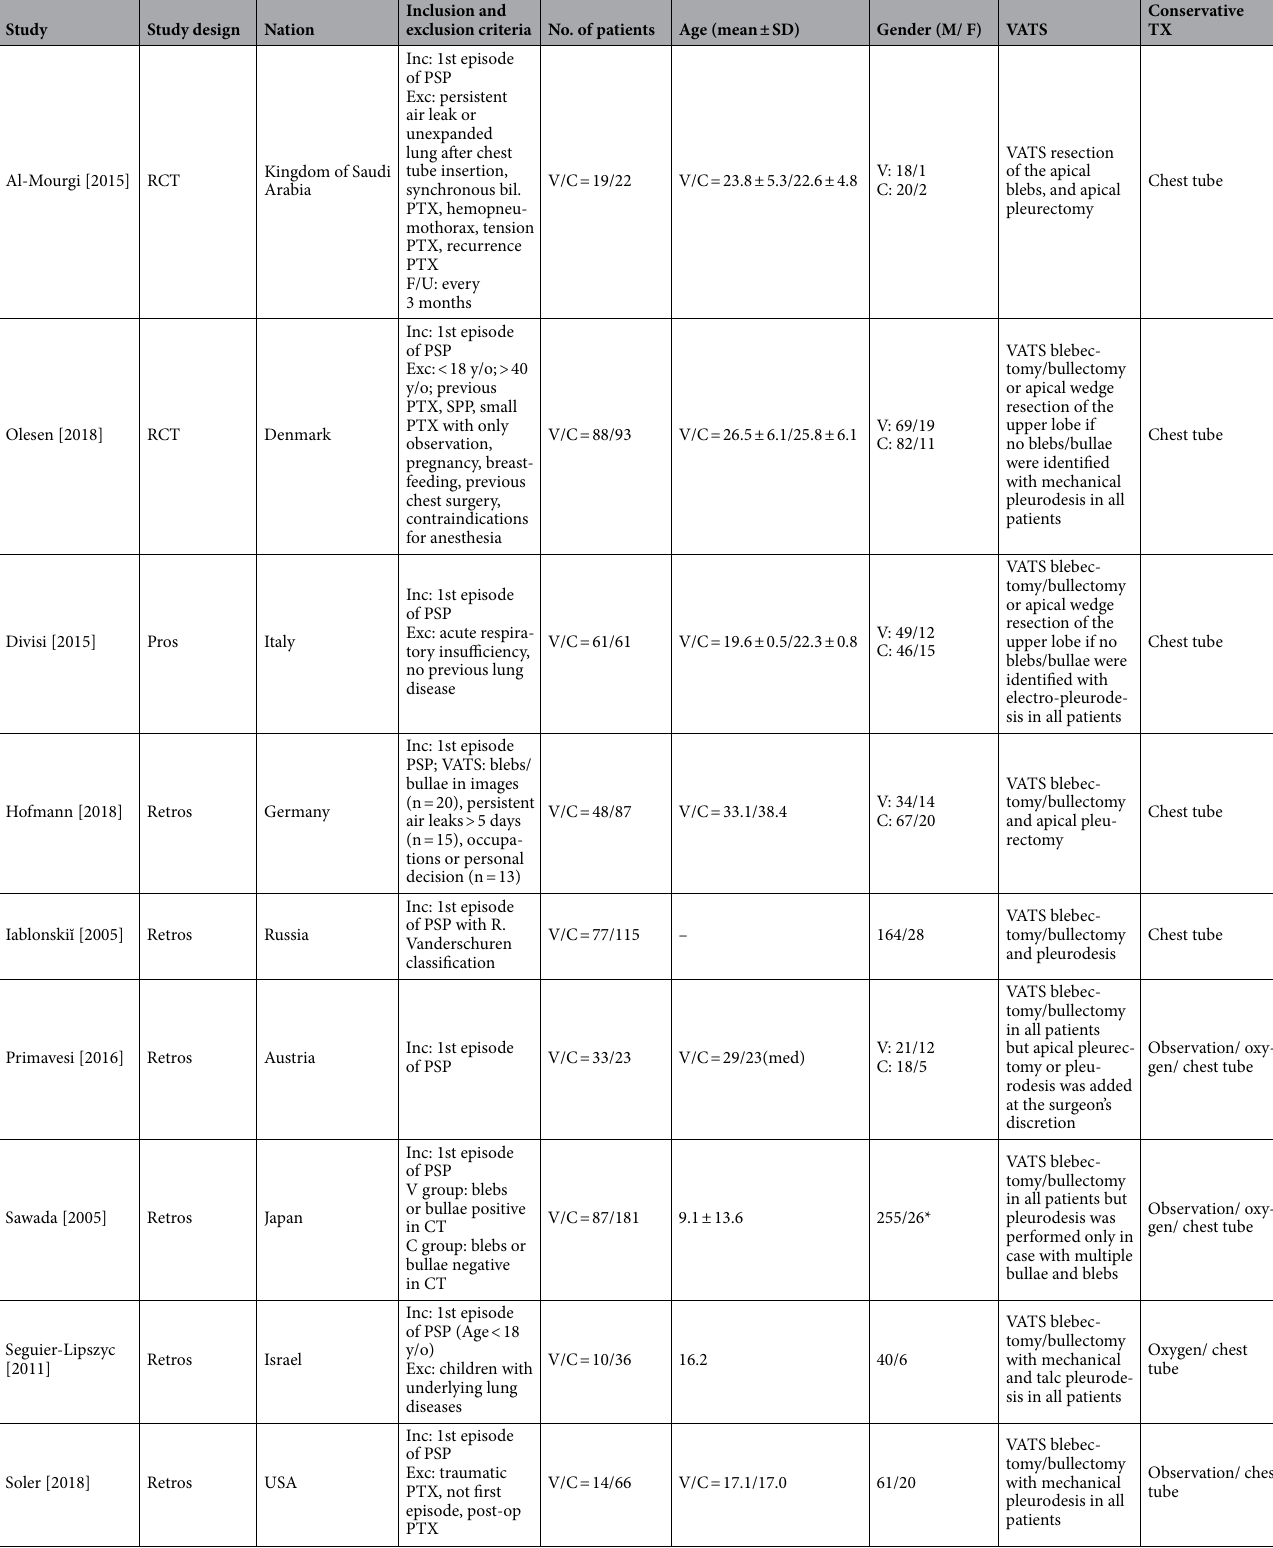
Table 1. Characteristics of studies that fulfilling the meta-analysis inclusion criteria. RCT randomized controlled trial, pros prospective, retros retrospective, Inc inclusion criteria, Exc exclusion criteria,